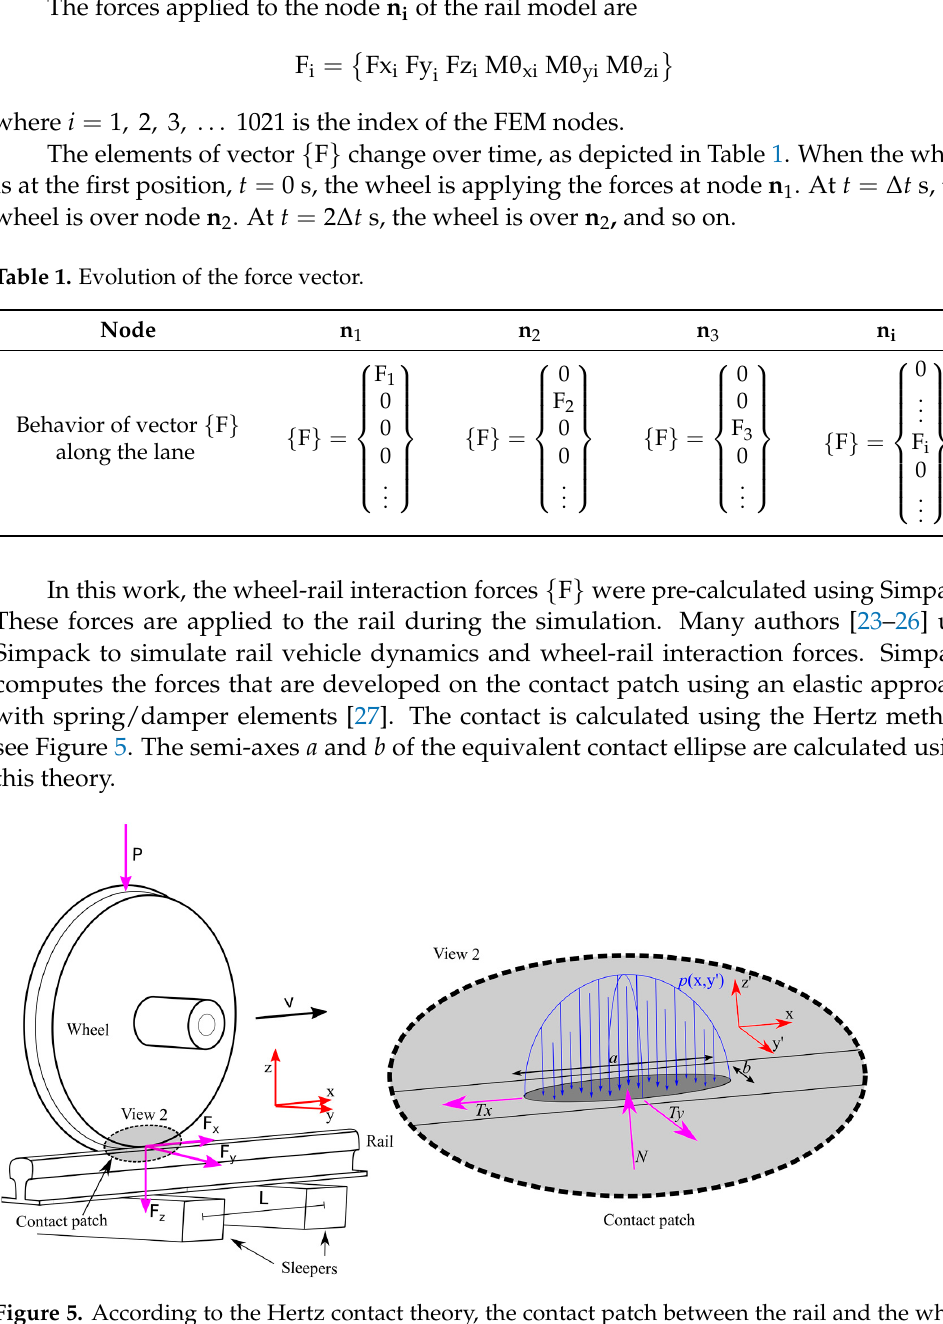
Figure 5. According to the Hertz contact theory, the contact patch between the rail and the wheel is an ellipse with semi-axis a and b . View 2 illustrates in detail the forces on the contact patch. The semi-axes of the contact patch depend on the magnitude of the force P. The forces applied by the wheel F x , F y , and F z , and the longitudinal velocity v cause the appearance of tangential forces T x , T y and a normal force N at the contact patch. The reference frame of the contact patch xy (cid:48) z (cid:48) change during the passage because of the conical shape and the oscillation of the wheel, and so it is slightly different from the orthogonal reference frame xyz (see Figure 6).